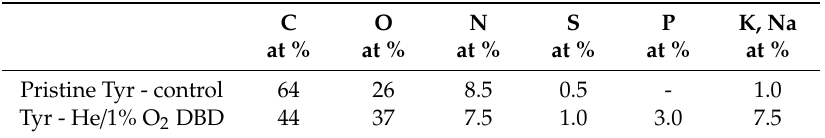
Table 2. XPS surface atomic concentrations of the dry Tyr deposit before and after 30 min exposure to the DBD fed with He / 1% O 2 mixture (f = 20 kHz, V a = 1.1 kV rms